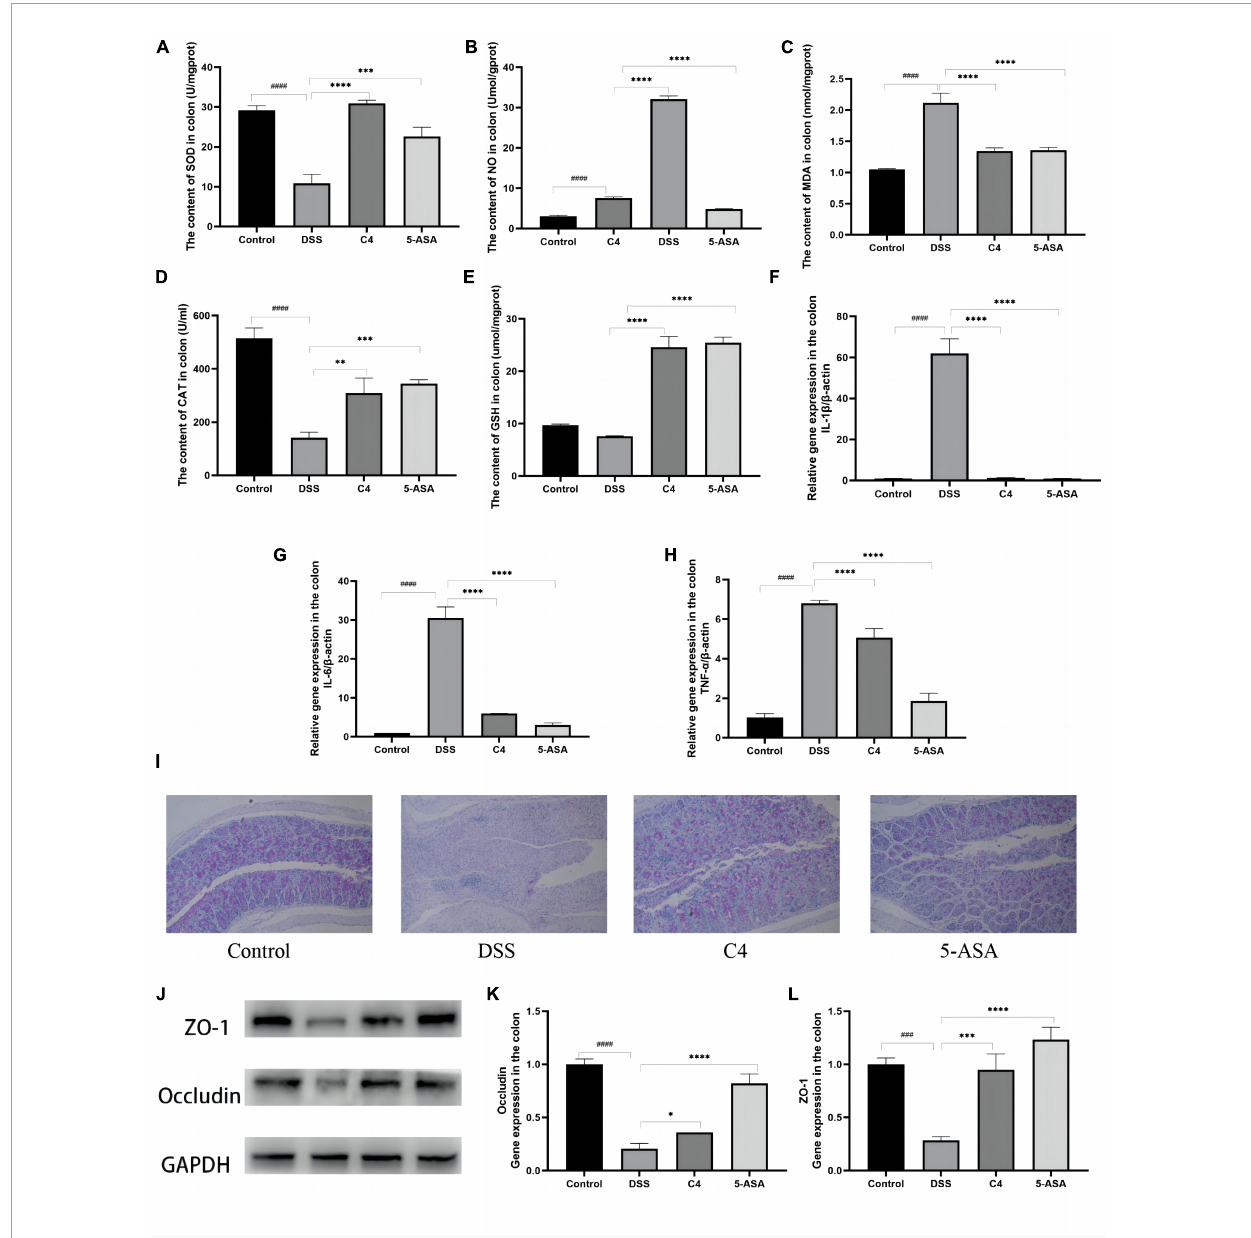
FIGURE2 Effect of the L. acidophilus C4 on oxidative stress and pro-inflammation expression. Data are subjected to one-way ANOVA statistics and presented as mean ± standard deviation ( n = 6). (A–E) Colon tissue oxidative stress. (F–H) Colon tissue inflammatory cytokines. (I) PAS staining of colonic tissue (400 fold magnification). (J) Protein expression of the TJ proteins Occludin and ZO-1 by Western blots. (K,L) mRNA levels of ZO-1 and Occludin by qRT-PCR. * P < 0.05, ** P < 0.01, *** P < 0.001 and **** P < 0.0001 vs. DSS group; ### P < 0.001 and #### P < 0.0001 vs. Normal